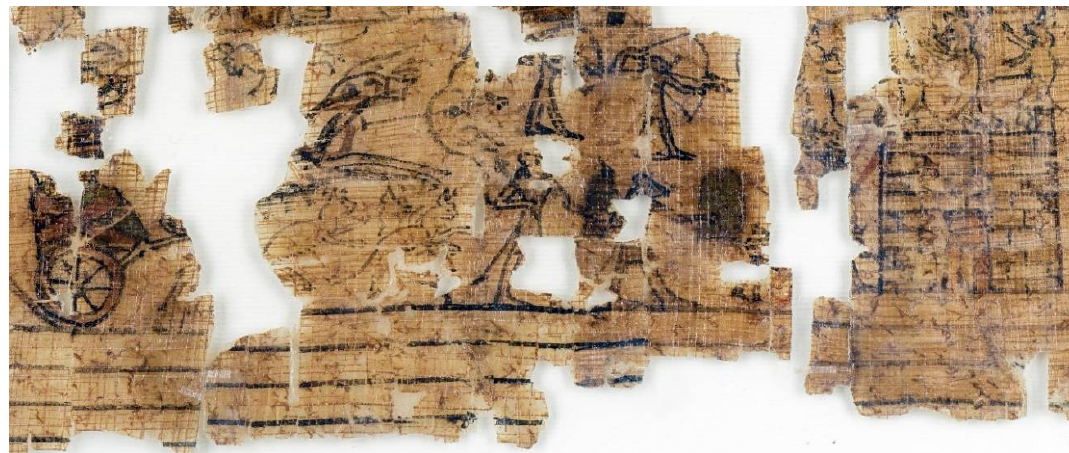
Figure 6. War of Mice and Cats (detail of CME inv. no. c.2031, CGT no. 55001), papyrus, Deir el-Medina, 20th Dynasty (Image courtesy of the Egyptian Museum, Turin).